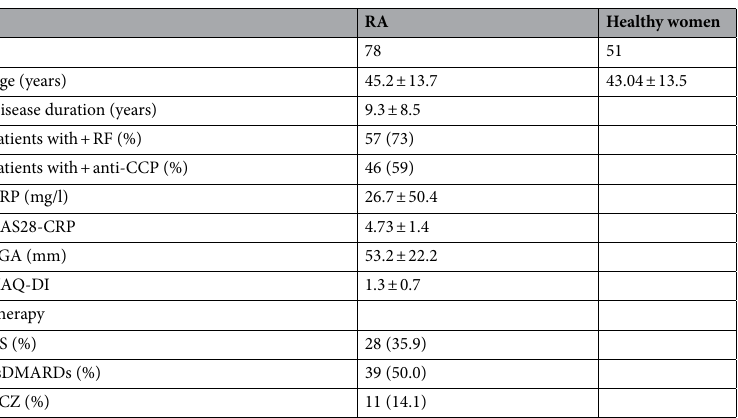
Table 4. Demographic characteristics and clinical data of female RA patients and healthy women. Data are presented as mean ± SD. Anti-CCP anti-cyclic citrullinated peptide antibody, CS corticosteroids, csDMARDs conventional synthetic DMARD, CRP C reactive protein, DAS28-CRP Disease Activity Score 28 calculated using C-reactive protein level, HAQ-DI Health Assessment Questionnaire Disability Index, PGA Patient Global Assessment (range: 0–100 mm), RA Rheumatoid arthritis, RF rheumatoid factor, SD standard deviation, TZC